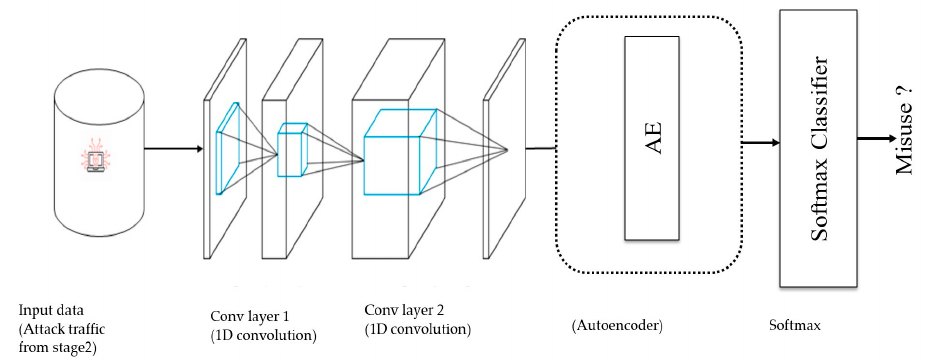
Figure 2. The micro overview Conv-AE.